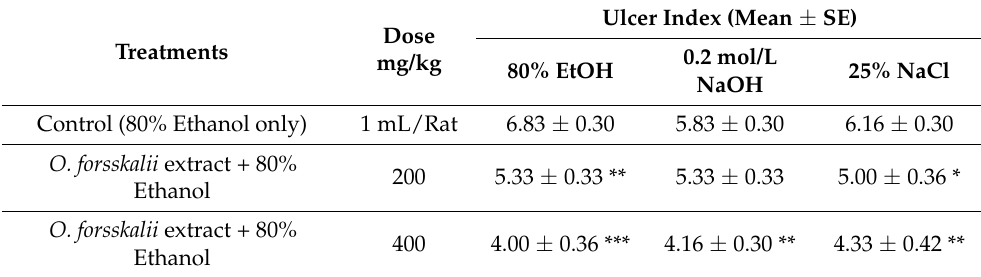
Table 4. Effect of O. forsskalii on gastric lesions induced by necrotizing agents. Treatments